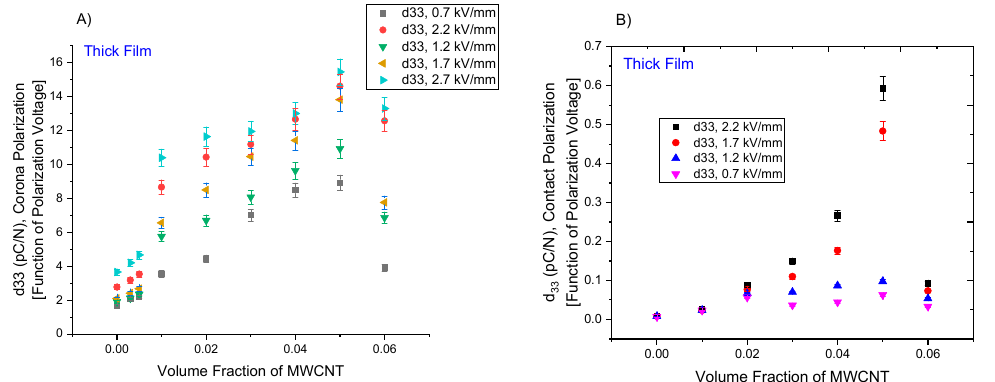
Figure 7. Piezoelectric strain coefficient, d 33 , for thick films as a function of polarization voltage and volume fraction of MWCNTs for ( A ) corona and ( B ) contact polarized samples.